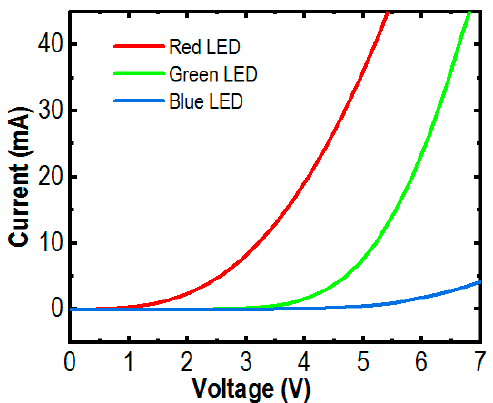
Figure 3. I-V characteristics of the RGB µ LEDs are illustrated.